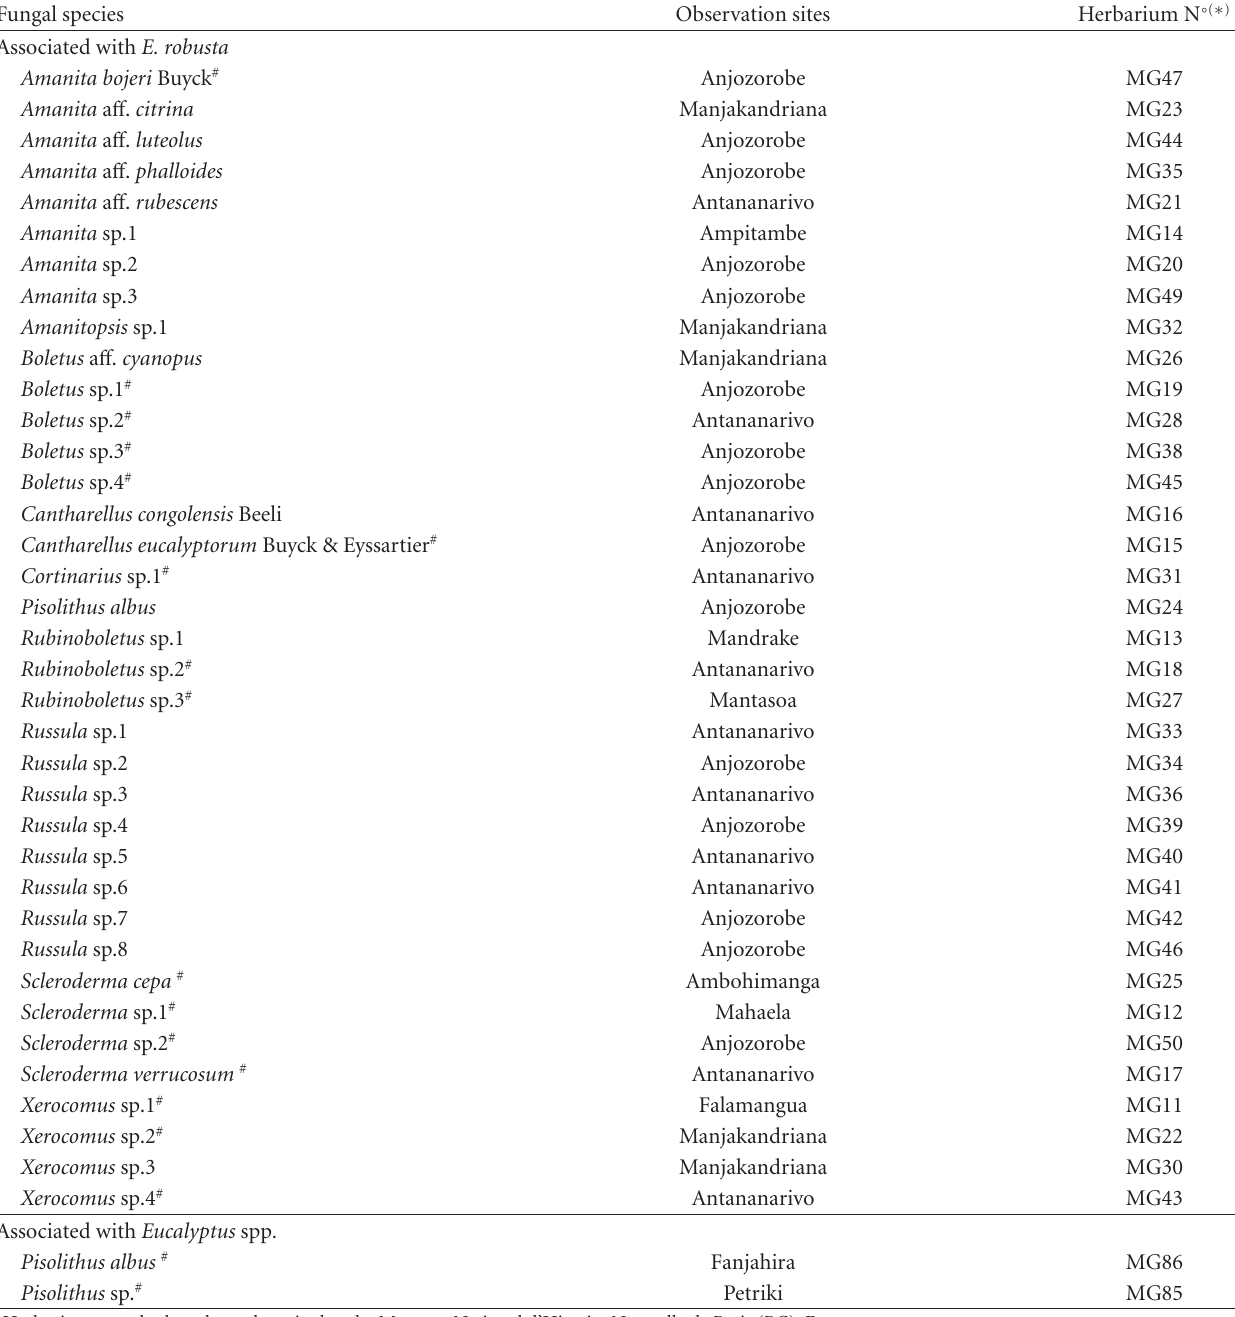
Table 3: List of ectomycorrhizal fungi found associated with Eucalyptus robusta and Eucalyptus sp. in Madagascar. Fungal